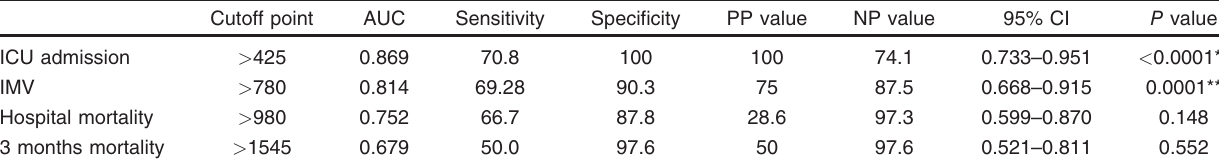
Table 6 Receiver operating characteristic curves result of B-type natriuretic peptide levels to predict ICU admission, invasive mechanical ventilation, hospital mortality, and 3 months mortality Cutoff point